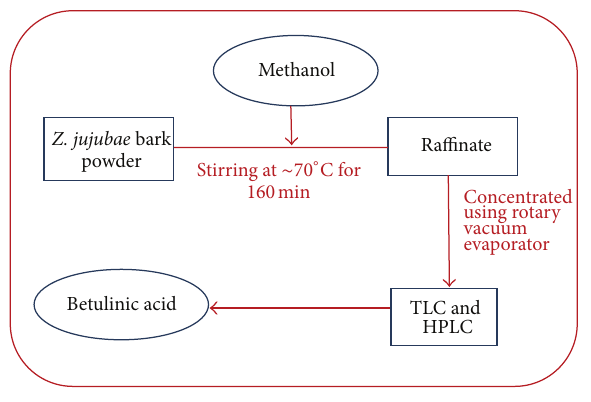
Figure 2: Line diagram for stirring extraction